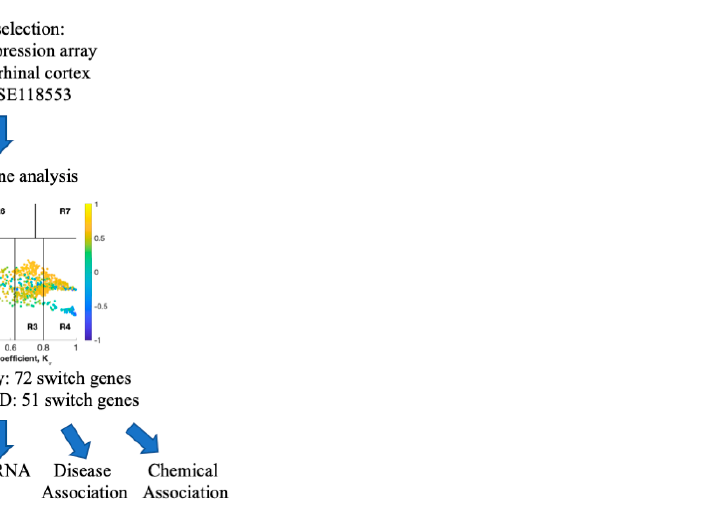
Figure 1. Flowchart of the study. SWIM analysis was performed to identify switch genes, which were further analyzed for functional pathways, regulatory transcription factors and miRNAs, and disease and chemical associations. AD: Alzheimer’s disease. AsymAD: asymptomatic AD. SWIM: SWItchMiner software.